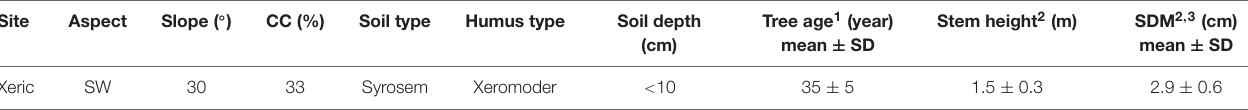
TABLE 1 | Site description and characteristics of selected Pinus sylvestris trees ( n =